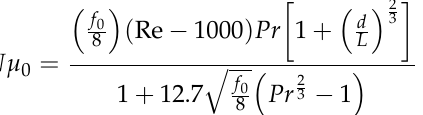
Figure 9. Comparisons of numerical results of friction factor with the data from Filonenko correla- tion. 5.2. Flow Characteristics To analyze the fluid flow and heat transfer characteristics in hemispherical and rhom- bus dimples channels, it is necessary to compare the calculation results with the result of reference [34]. Figure 10 shows the effect of Reynolds numbers on the Nusselt number of the dimpled channel with different dimple shapes. As Reynolds number increase, the Nusselt number of all channels increases. The Nusselt number of hemispherical dimple channel varies from 50 to 278, which is 1.16 times than that of a rhombus dimpled channel. Comparing to the hemispherical dimple channel, the Nusselt number of rhombus dimple